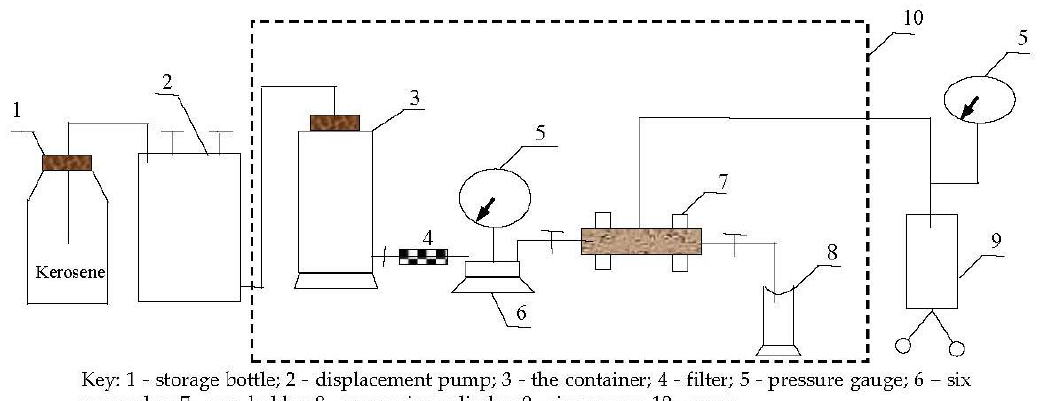
Figure 2. Diagram of the experimental setup.